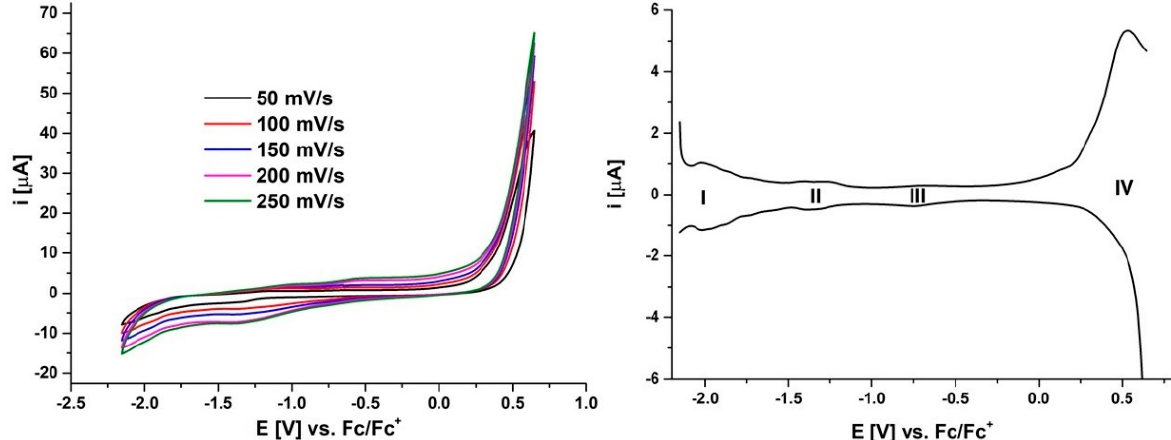
Figure 3. The cyclic and differential pulse voltammograms of porphyrazine 5 in 0.1 M TBAP/DCM. The DPV parameters: modulation amplitude 20 mV and step rate 5 mV·s − 1 .